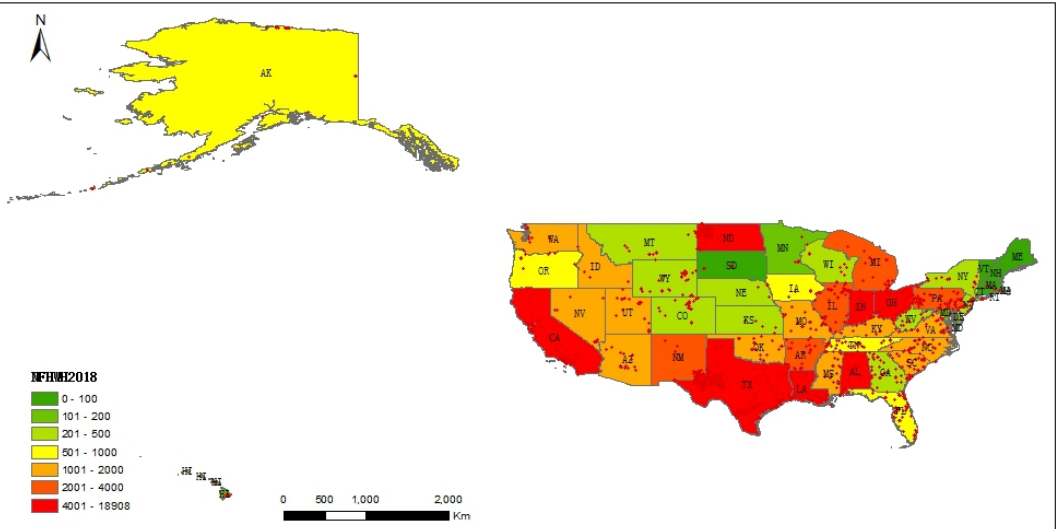
Figure 10. Numbers of hotspots representing active industrial heat releasers in different states in the US